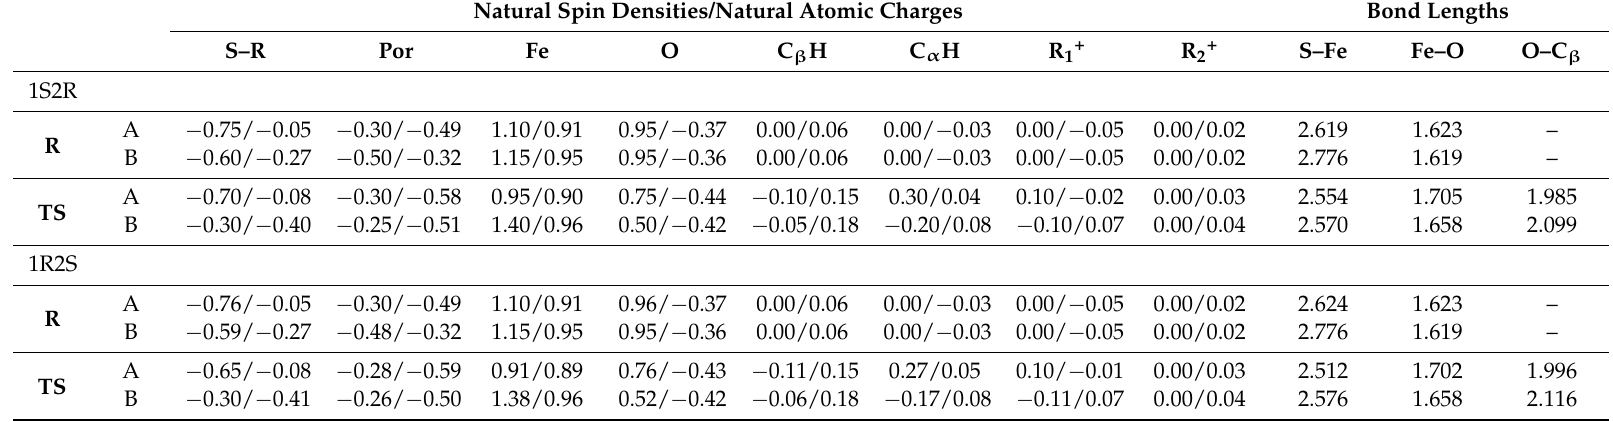
Table 1. Natural group spin densities/charges and bond lengths (Å) of the optimized structures on the doublet spin potential energy surfaces (PES). Natural Spin Densities/Natural Atomic Charges Bond